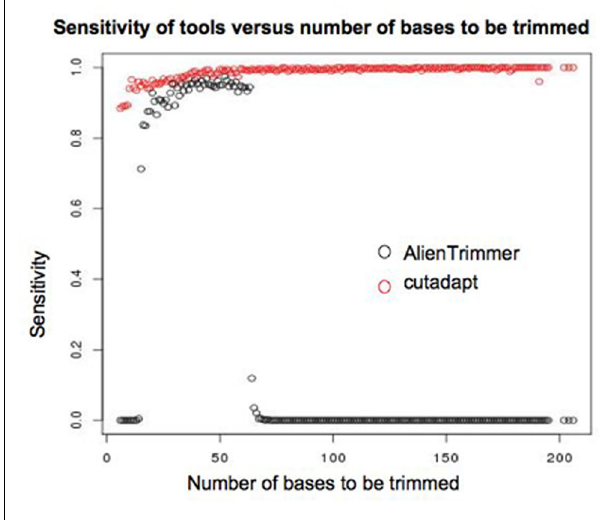
FIGURE 8 | Plot showing how the sensitivity ofAlienTrimmer (with a k-mer value of 10) and cutadapt varies according to the length of adapter sequence expected to be trimmed based on insert size estimated by